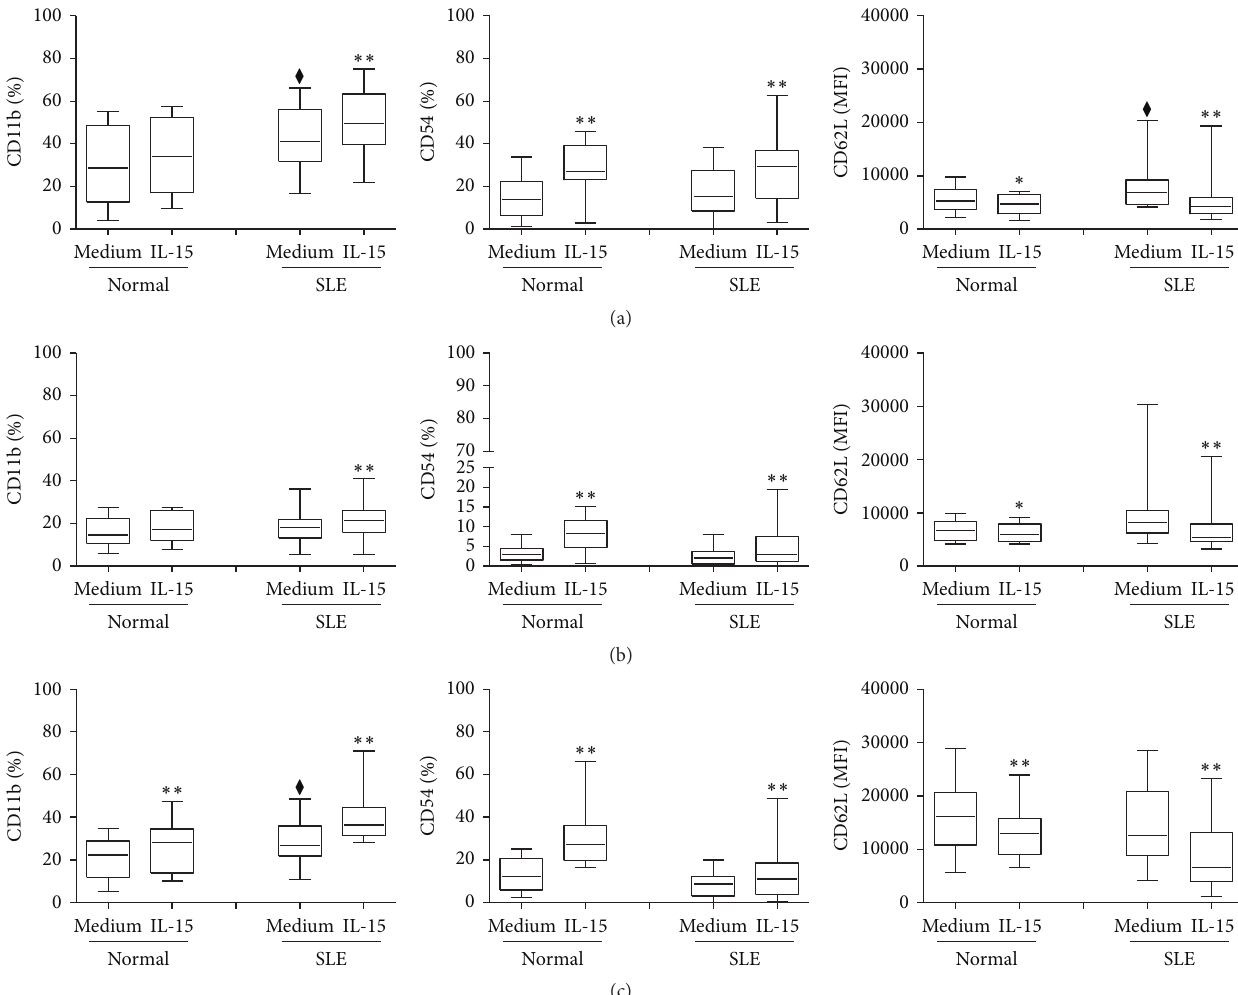
Figure 1: The CD11b, CD54, and CD62L expression on (a) CD56 + CD3 − NK cells, (b) CD56 − CD3 + T cells, and (c) CD56 + CD3 + NKT-like cells from SLE patients and healthy controls. PBMCs were stimulated with IL-15 (10ng/mL) for 18 hrs. Cells were stained by anti-CD3 and anti- CD56 antibodies and segregated into CD56 + CD3 − NK cells, CD56 − CD3 + T cells, and CD56 + CD3 + NKT-like cells. Surface marker (CD11b, CD54, or CD62L) expression on each cell population was analyzed by flow cytometry. Data was expressed as percent expression (%) ± SEM. ⧫ 𝑝 < 0.05 compared to normal; ∗ 𝑝 < 0.05/ ∗∗ 𝑝 < 0.01 compared to medium (normal, 𝑛 = 17 ; SLE, 𝑛 = 33